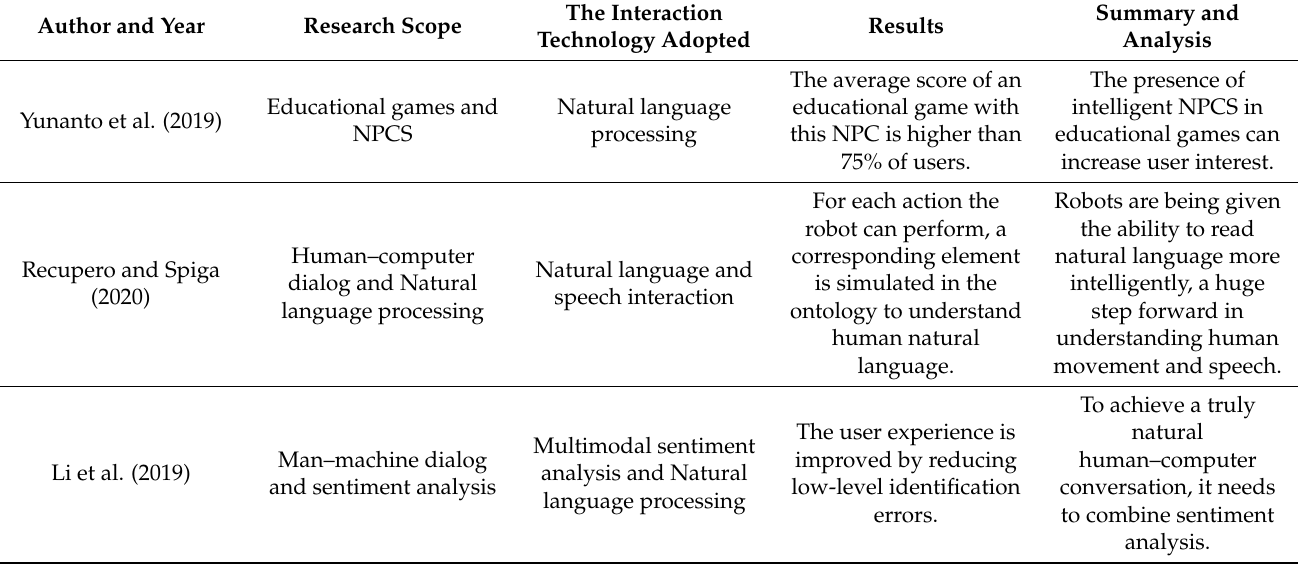
Table 3. Development status of human–computer interaction in natural language